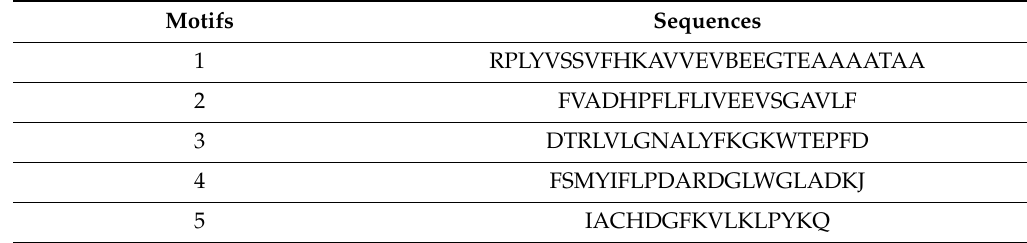
Table 1. Motifs found in the serpin